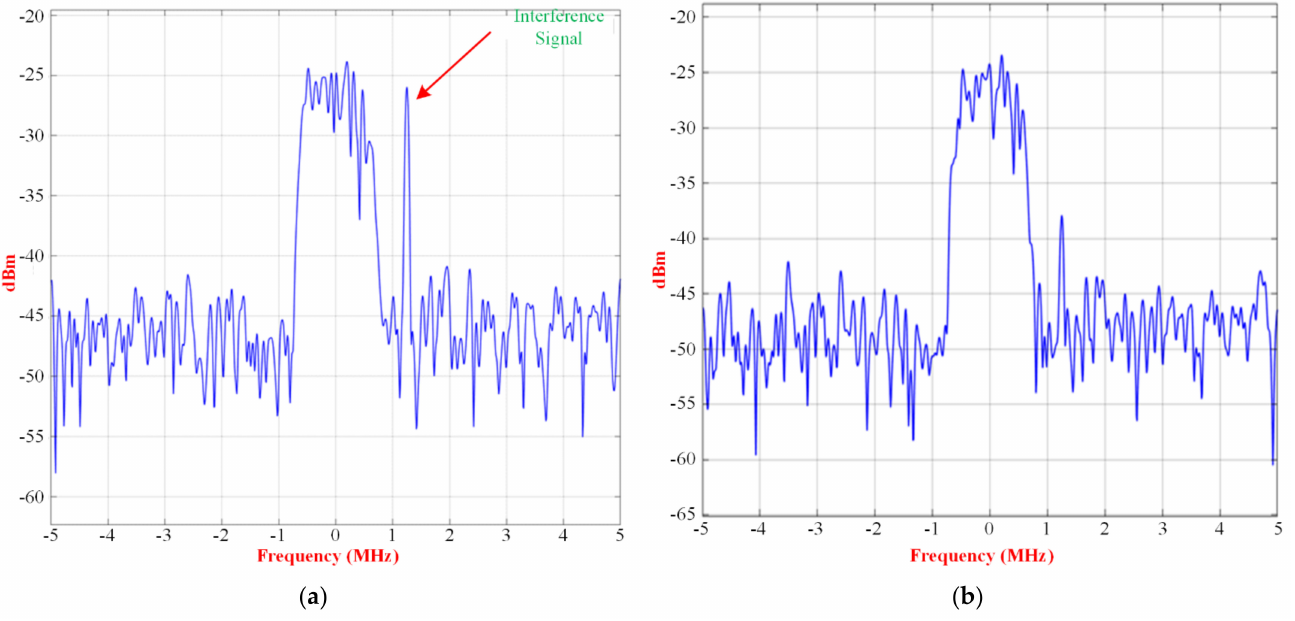
Figure 25. Signal and interference input spectrum of the RF receiver for case 1 ( a ) without beamform- ing, and after ( b ) with